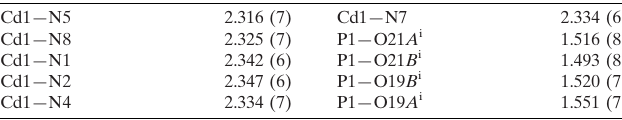
Selected bond lengths (A˚ ).